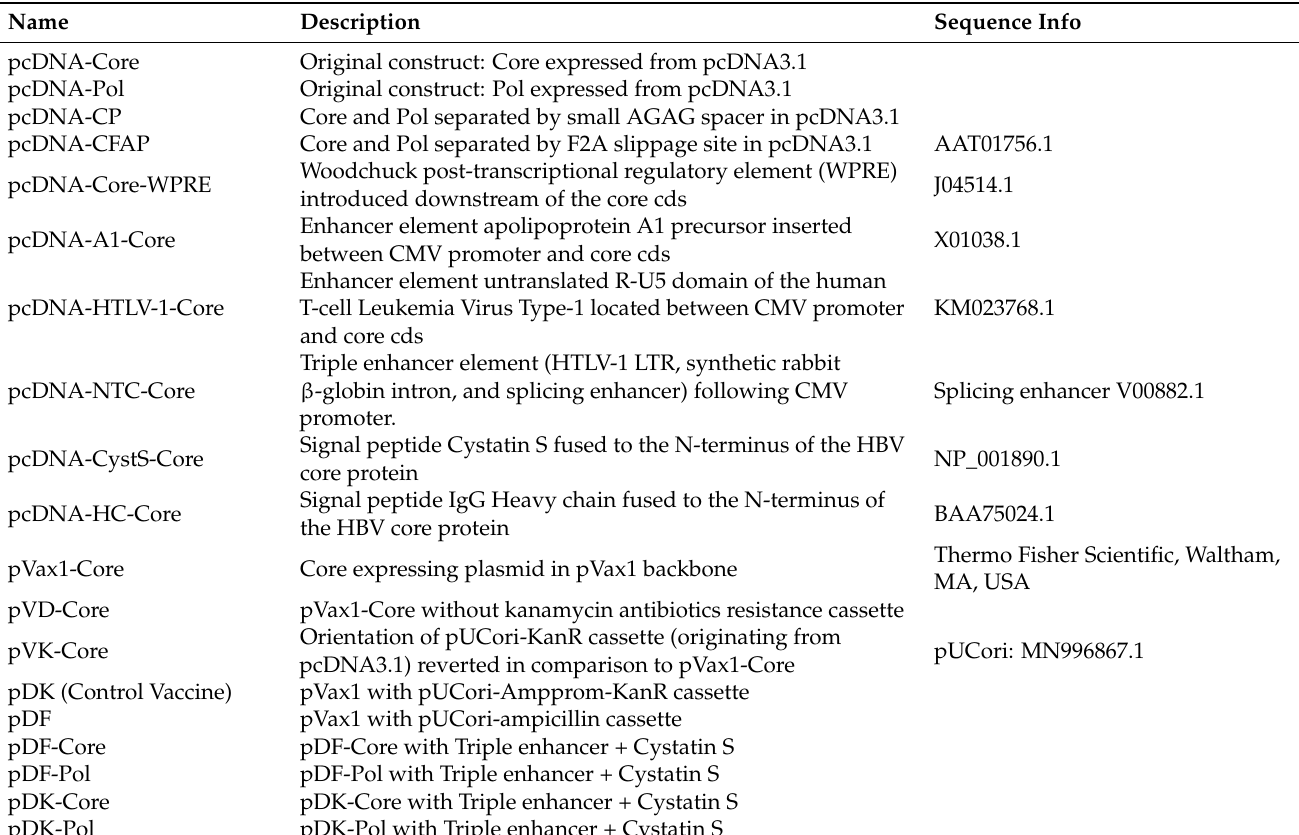
Table 1. Overview of all plasmids tested for optimal expression and secretion of Core and Pol. The table lists the names of the plasmids used in the studies with the corresponding backbone, encoded HBV protein, and a description of key